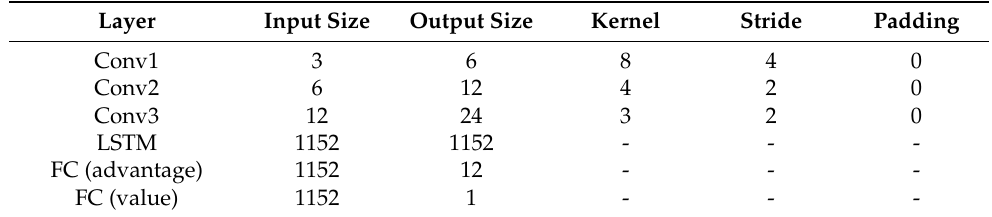
Table 1. Parameter Setting for the Global Path Planning Network.